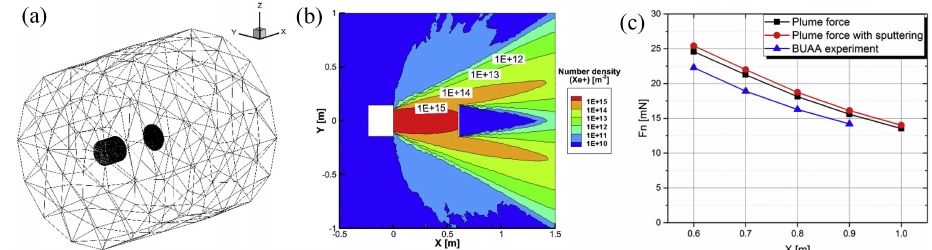
Figure 16. ( a ) Computational domain of a surface immersed in the plasma plume flow of the LIPS-200 ion thruster. ( b ) The number density simulated by EX-PWS. ( c ) Force exerted on the immersed surface simulated by EX-PWS